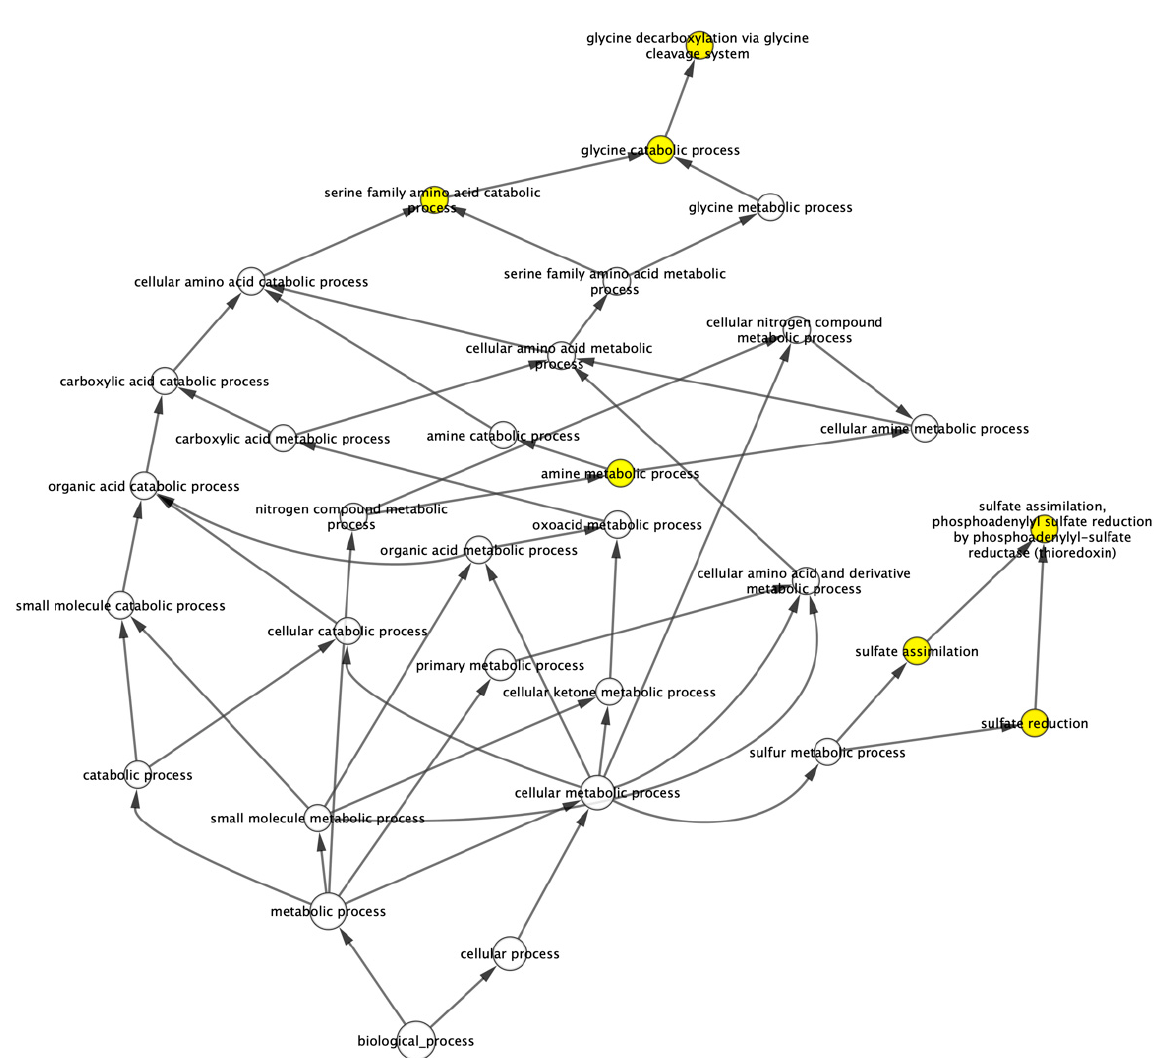
Figure 3. Enriched GO terms (colored in yellow, adjusted p value < 0.05) for down-regulated DEGs identified in the Wz- H isolate using BiNGO.